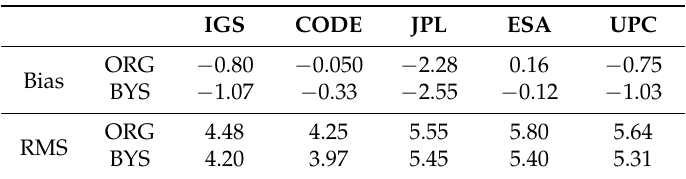
Table 1. Differences in VTEC maps based on original LSE and Bayesian approaches compared with IAAC GIMs (unit: TECU).